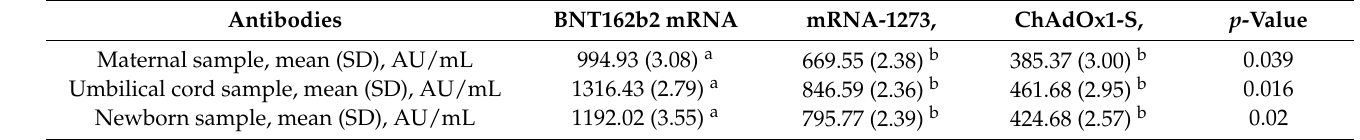
Table 3. Anti-Spike 1 and 2 IgG Comparison between the most frequent homologous vaccination